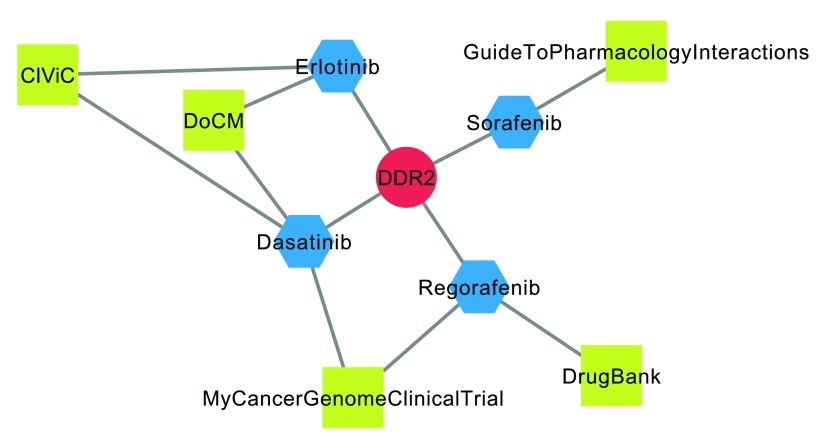
Drug-gene interactions illustrated as a network with
DDR2 in the middle (red) and interacting drugs (blue) connected to the gene.Resources that report a specific drug-gene interactions are colored in green.